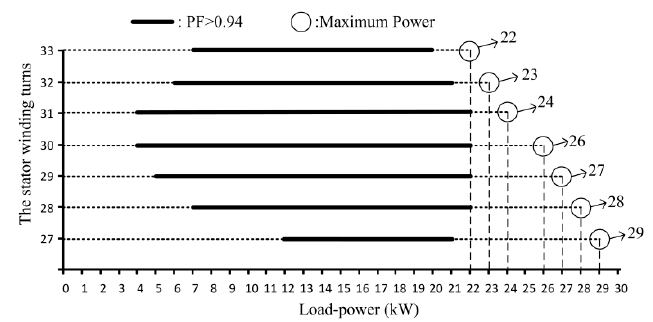
Figure 10. PF and maximum power versus load power.